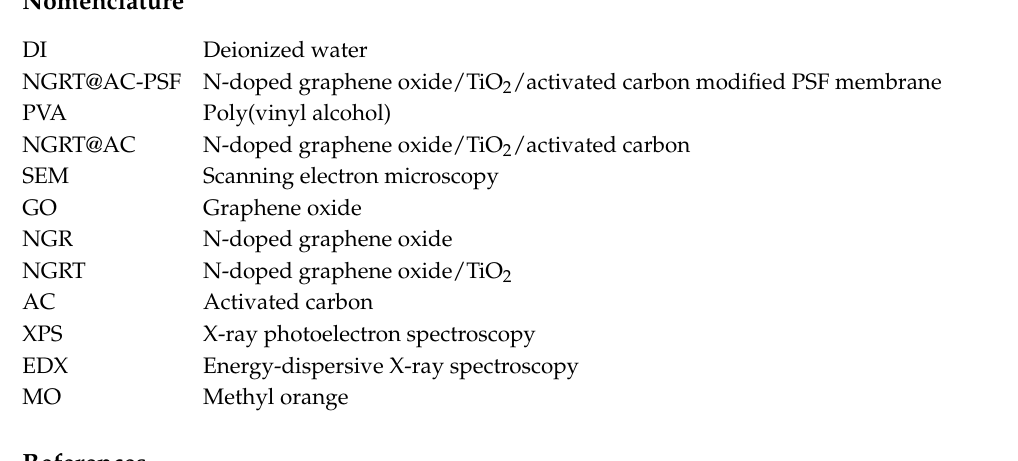
Figure S1: Schematic diagrams of the lab scale cross-flow UF system, Figure S2: The photocatalytic performance of different preparation methods, Figure S3: The effect of different nanoparticles contents on photocatalytic performance, Table S1: The detailed information of different elements contents of NGRT@AC